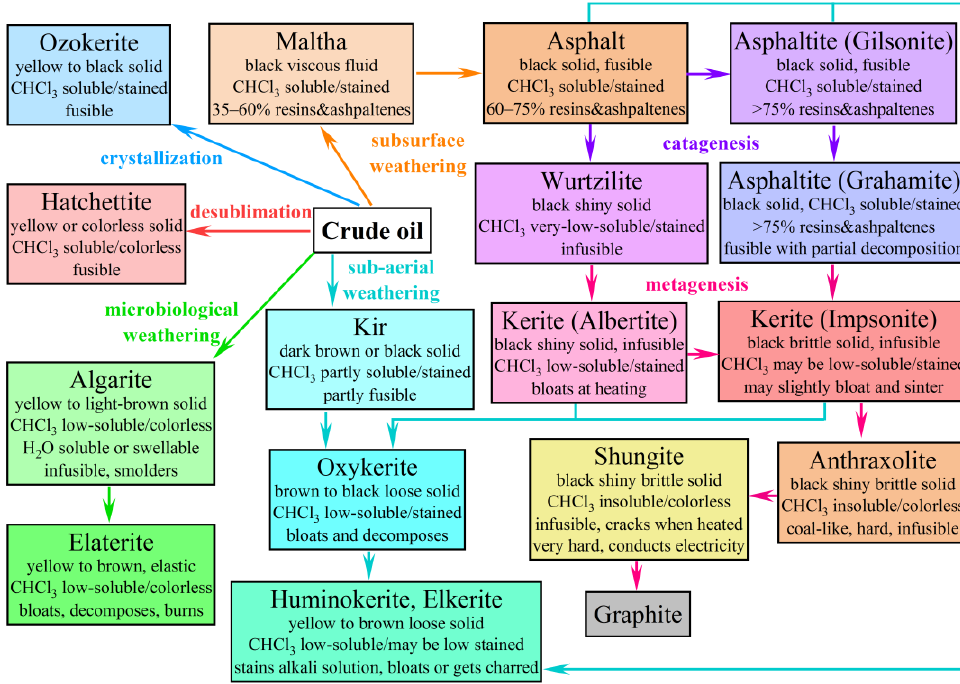
Figure 1. An approximate scheme of relations between the main genetic types of bitumens and ways of their formation and transformation. The inscriptions near the arrows and their colors indicate the bitumen conversion paths, while the rectangles contain names of bitumens, their visual characteristics, and their behavior when heated or in contact with a solvent.